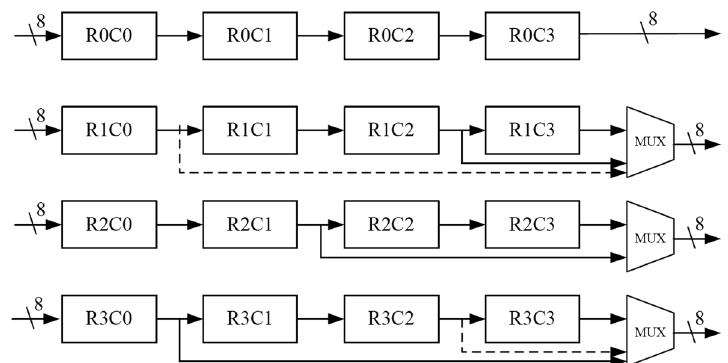
Fig. 6 ShiftRows operations in encryption and